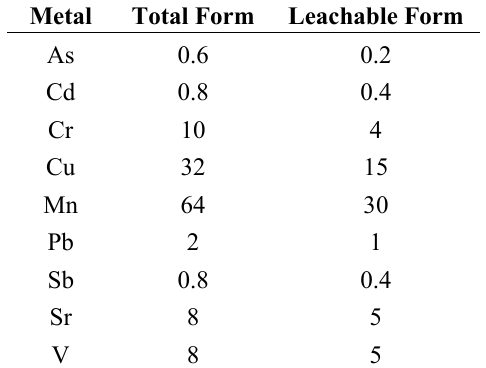
Table 2. Limits of quantification ( μ g·m − 2 ) of the total and leachable